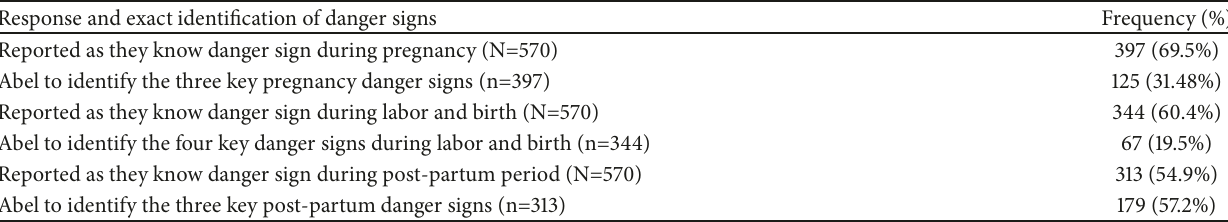
Table 3: Knowledge of obstetric danger sign among study participants in Jardega Jarte District, Oromia Region, Western Ethiopia, from January 1 to February 2, 2016.